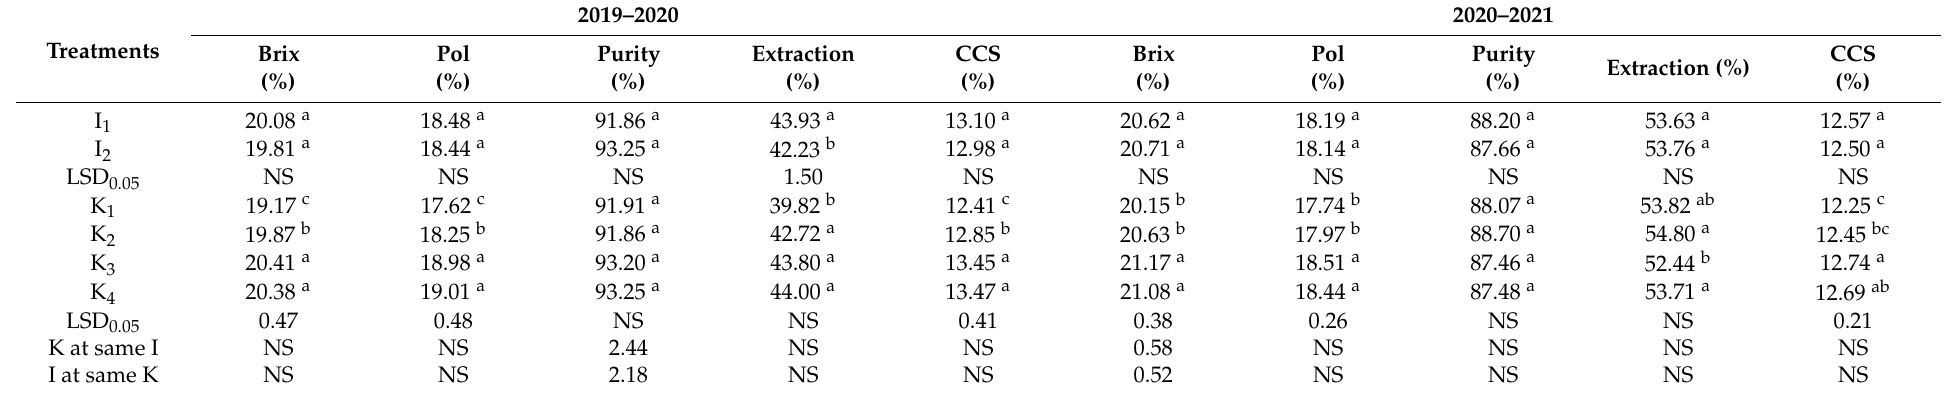
Table 9. Sugarcane quality parameters at 10th months as a function of irrigation and potash